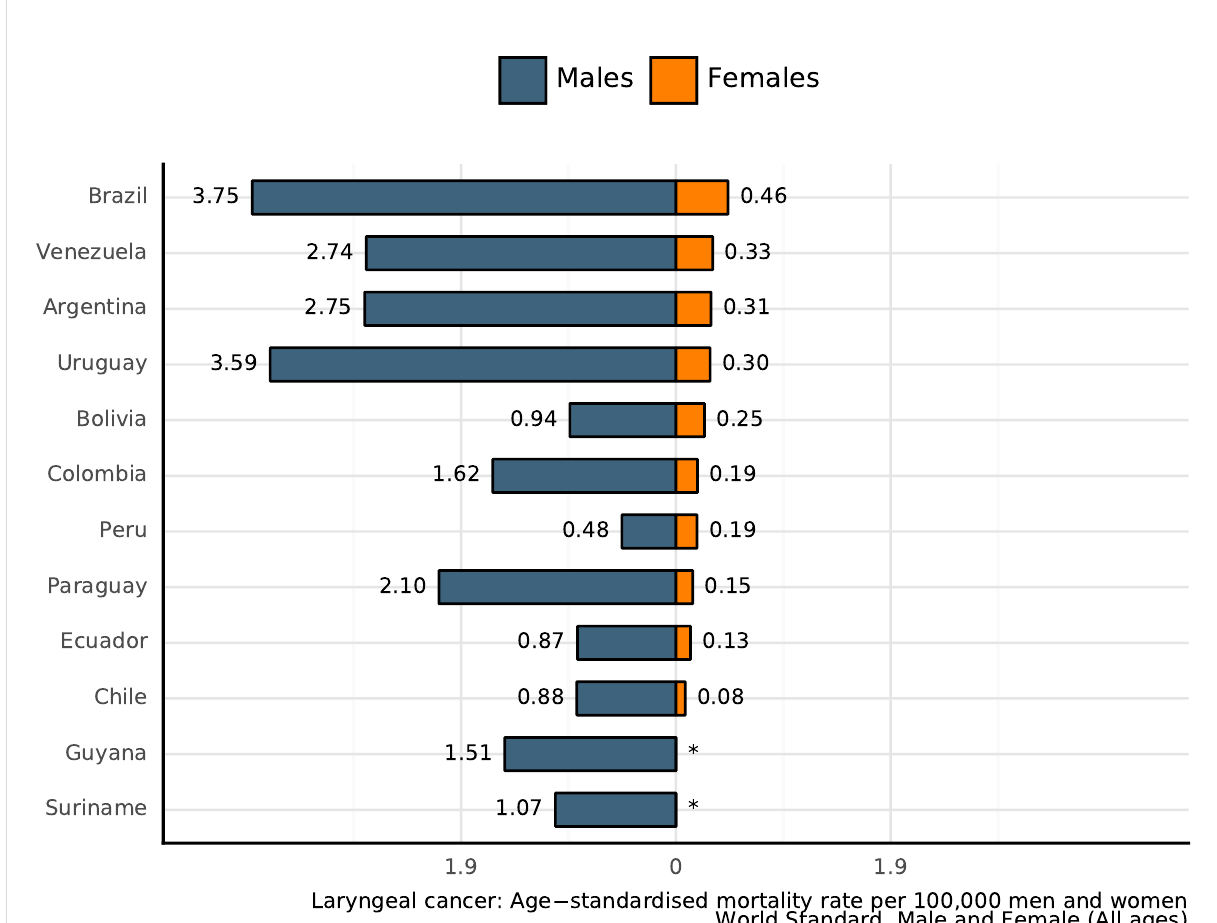
Laryngeal cancer: Age standardised mortality rate per 100,000 men and women World Standard. Male and Female (All